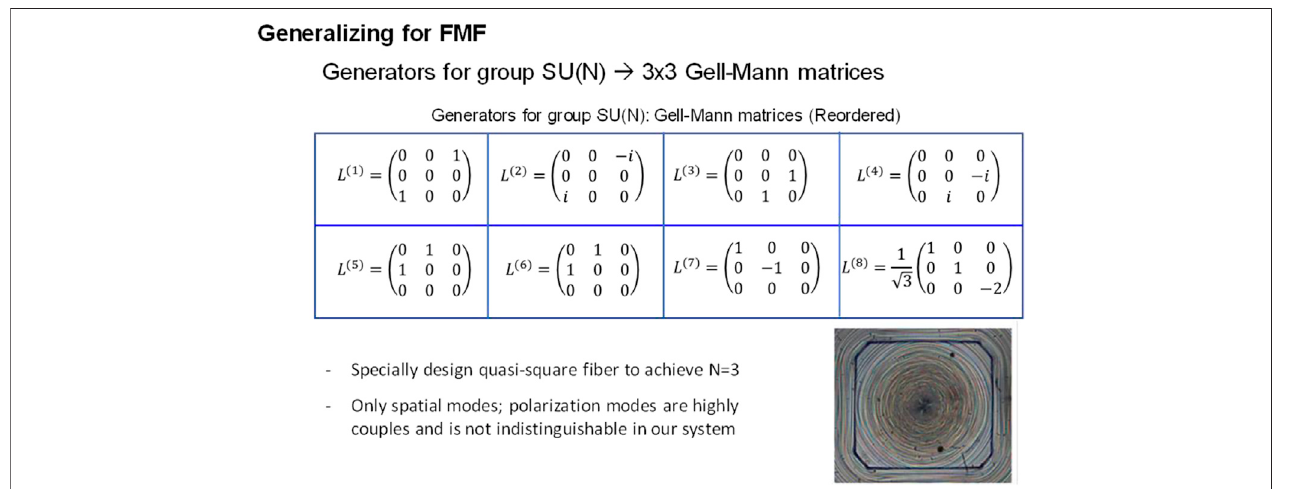
FIGURE 6 | Gell Mann matrices used to generate the modal launch conditions for a 3 mode fi ber.